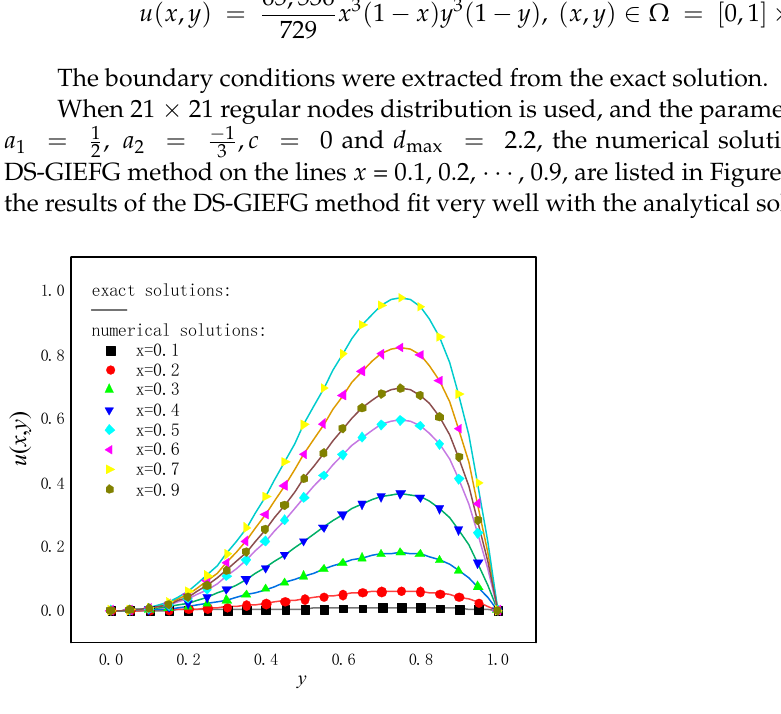
Figure 2. The numerical solutions of the DS-GIEFG method with the 21 × 21 regular nodes and ε = 10 − 9 , a 1 = − 1/3, a 2 = 1/ 2 .